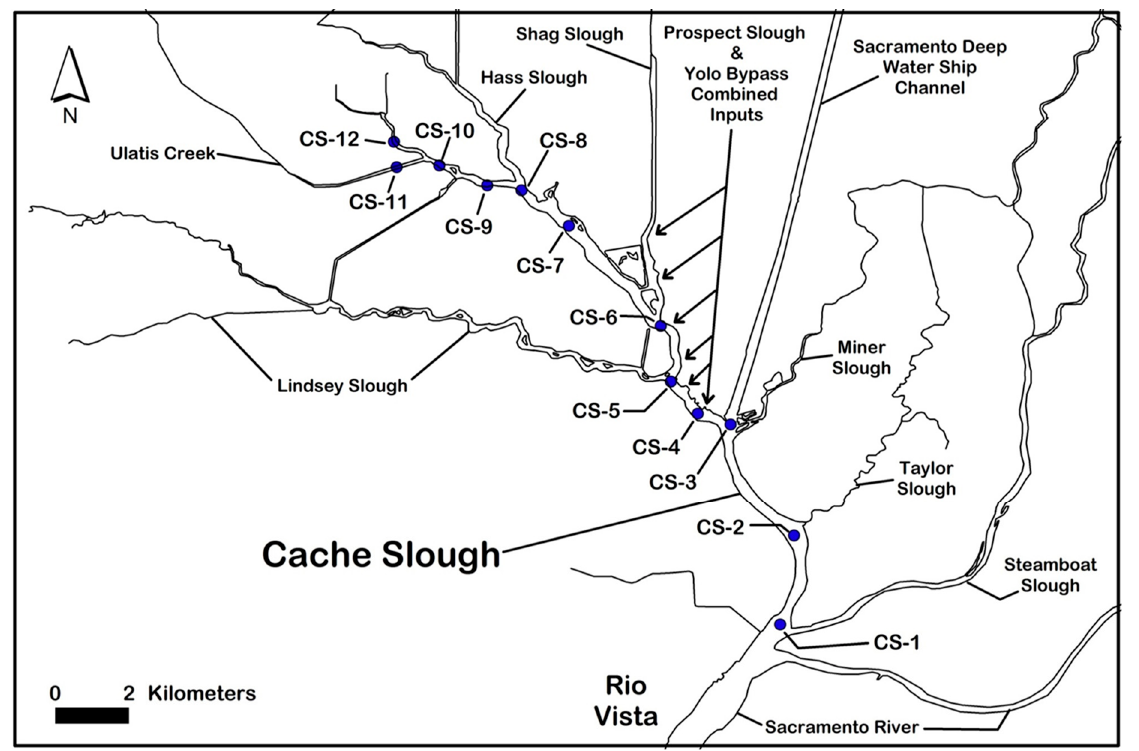
Figure 1. Twelve Cache Slough sites sampled during the spring and fall of 2012, 2013 and 2014.